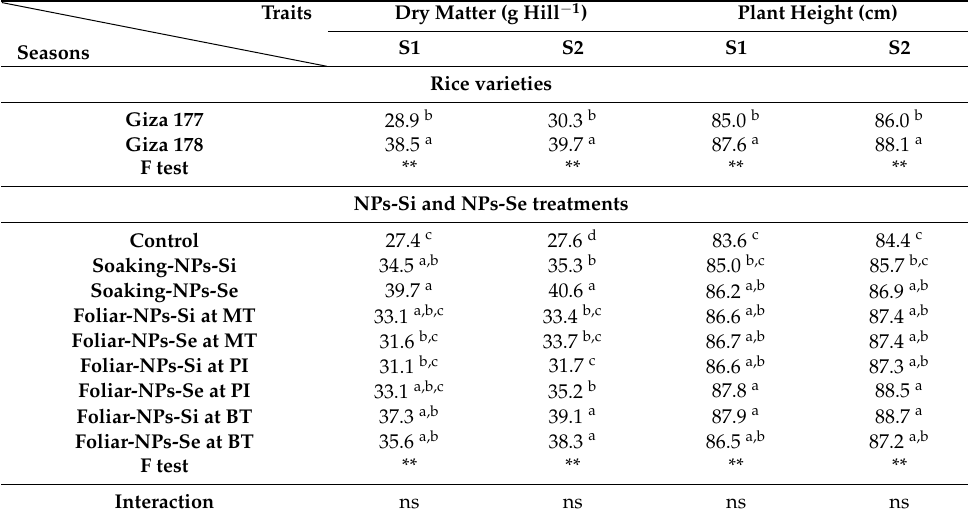
Table 5. Effect of NPs-Si and NPs-Se treatments on dry matter and plant height of two rice varieties under saline soil conditions in the 2018 (S1) and 2019 (S2) seasons.